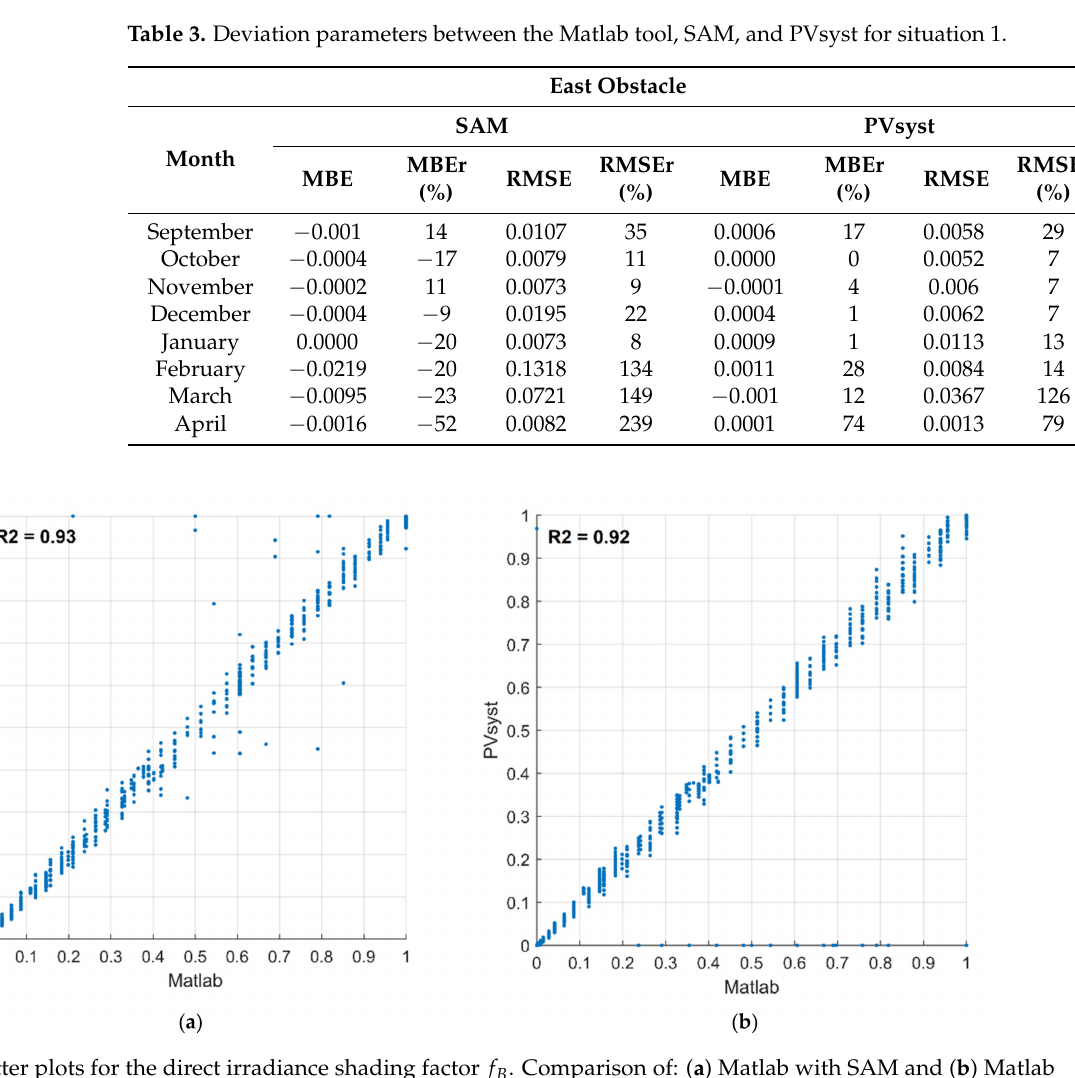
Figure 19. Scatter plots for the direct irradiance shading factor f B . Comparison of: ( a ) Matlab with SAM and ( b ) Matlab with PVsyst. Results are for situation 1, one module shaded by a single obstacle positioned on the east side.